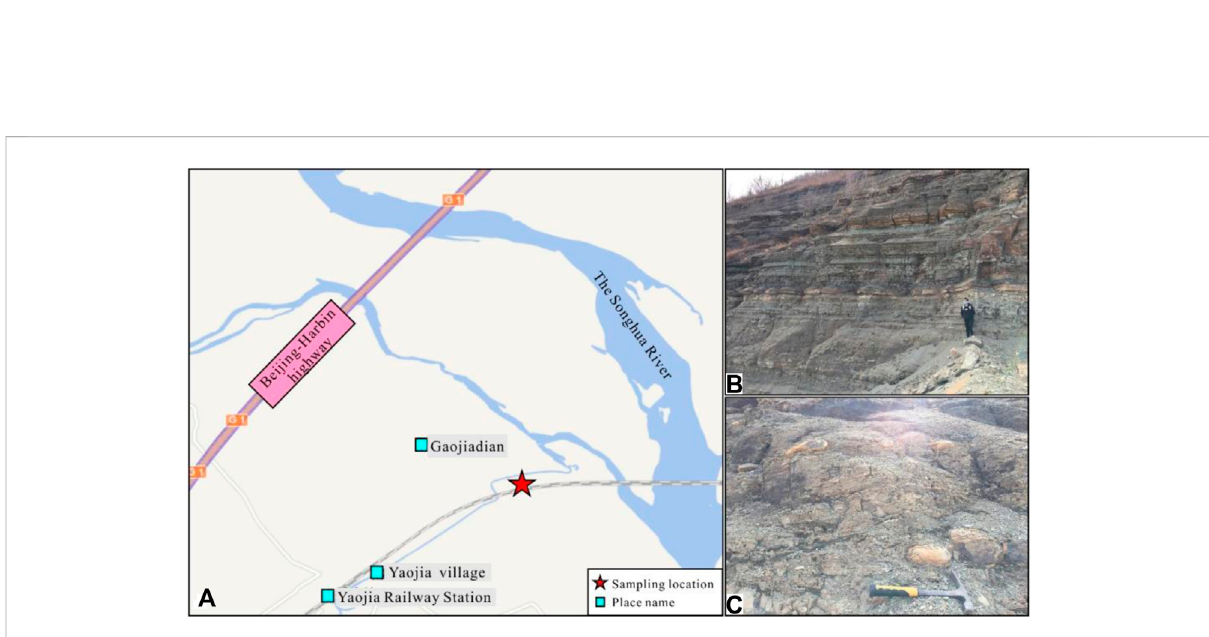
FIGURE 3 Location of the sampling site and fi eld photographs. (A) Location of the sampling site, southeast of the Songliao Basin; (B) Sampling pro fi le; (C) Concretion